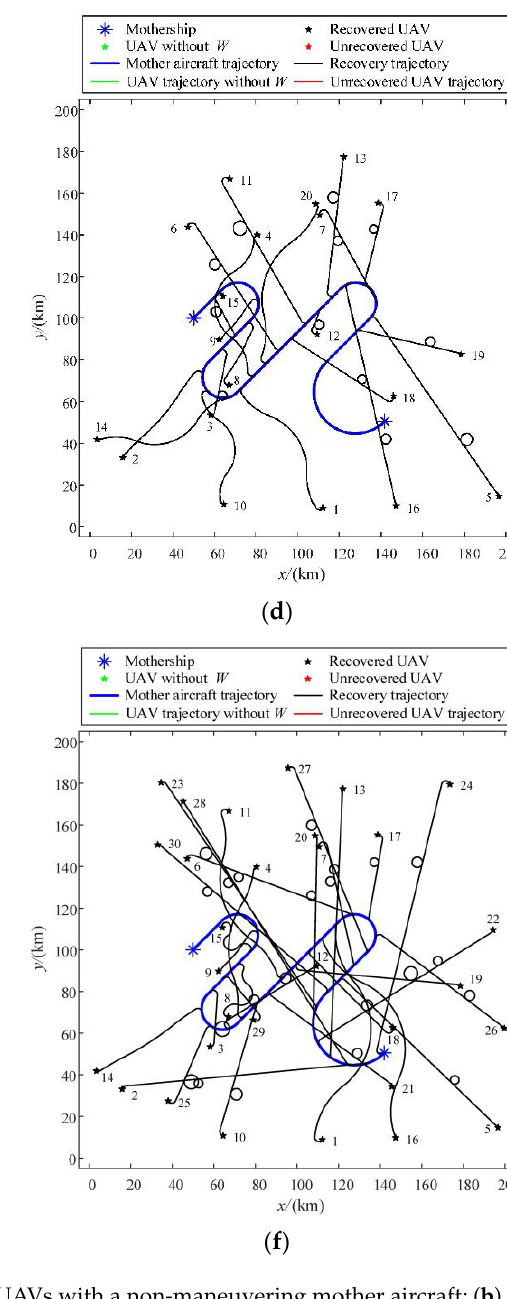
Figure 11. Representative recovery results. ( a ) 10 UAVs with a non-maneuvering mother aircraft; ( b ) 10 UAVs with a maneuvering mother aircraft; ( c ) 20 UAVs with a non-maneuvering mother aircraft; ( d ) 20 UAVs with a maneuvering mother aircraft; ( e ) 30 UAVs with a non-maneuvering mother aircraft; ( f ) 30 UAVs with a maneuvering mother aircraft.